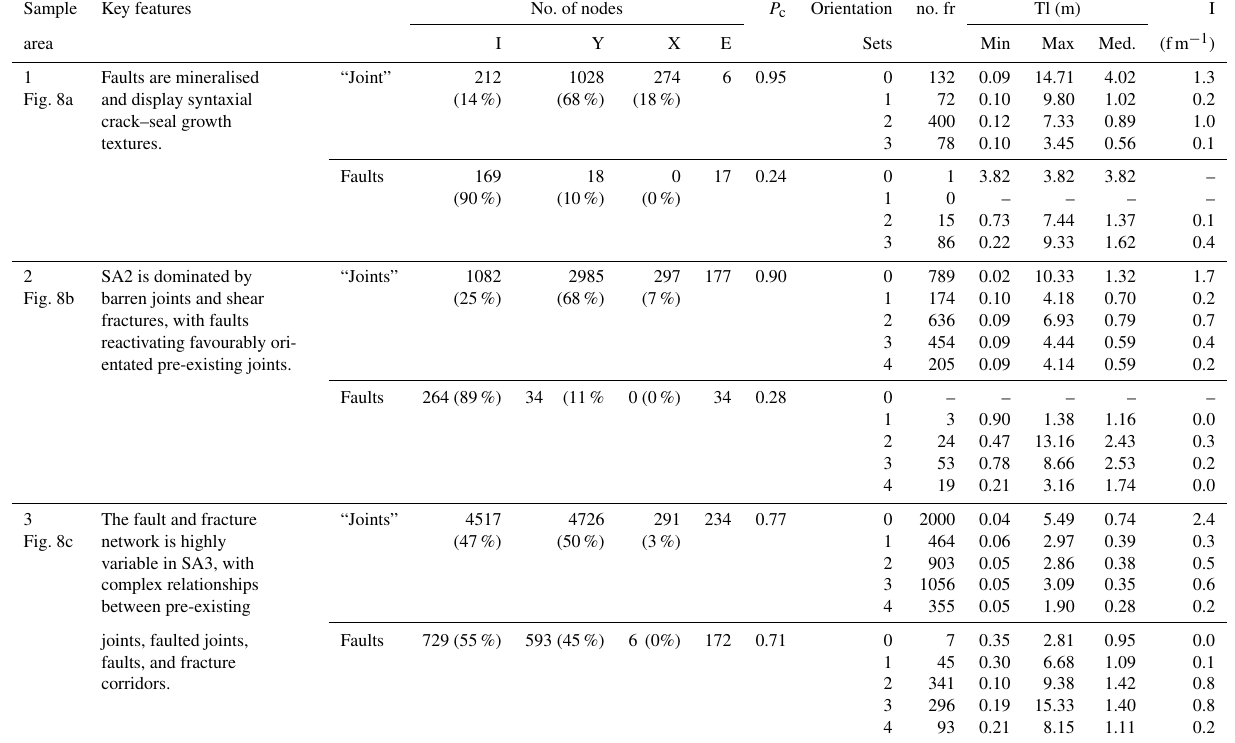
Table 3. Network characteristics of the joint and fault datasets presented for the three sample areas outlined in Fig. 8. Please note that because the fault network is superimposed onto the joint network, I-nodes (i.e. where a fault terminates) can represent a Y-node in the combined network. Similarly, where a joint terminated against a fault, due to the sealing properties of the fault, it is no longer appropriate to classify this as a connected branch and as such is classified as an I-node in the “joint network”. The percentage of each node classification is provided in brackets following the number of node counts. Trace length data are presented as orientation sets that were derived following visual assessment of length-weighted rose diagrams and do not relate to the age sets outlined in Fig. 8. For the combined network fracture statistics and trace length distributions for all datasets please refer to Fig.